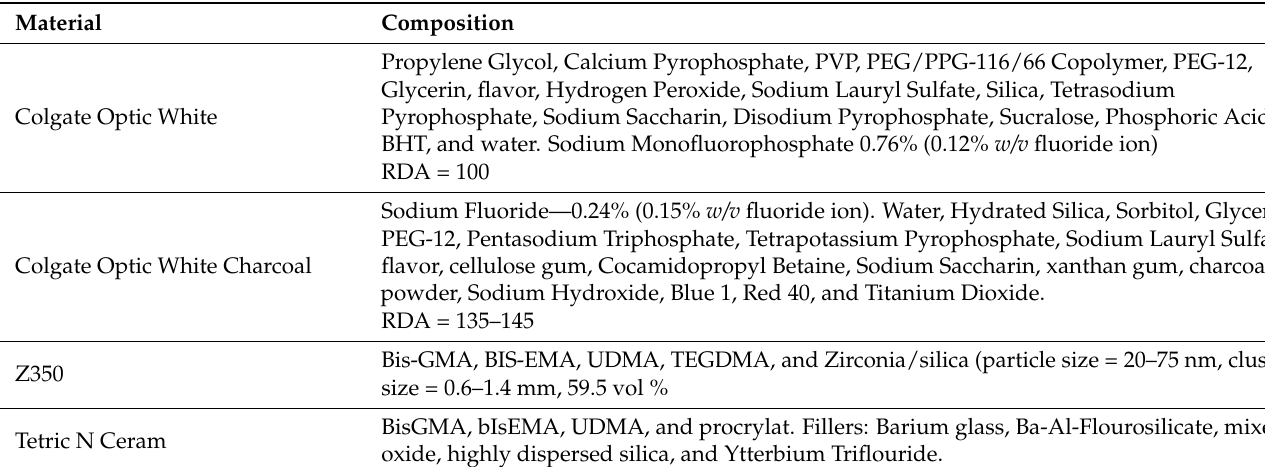
Table 1. Composition of dentifrice and composite